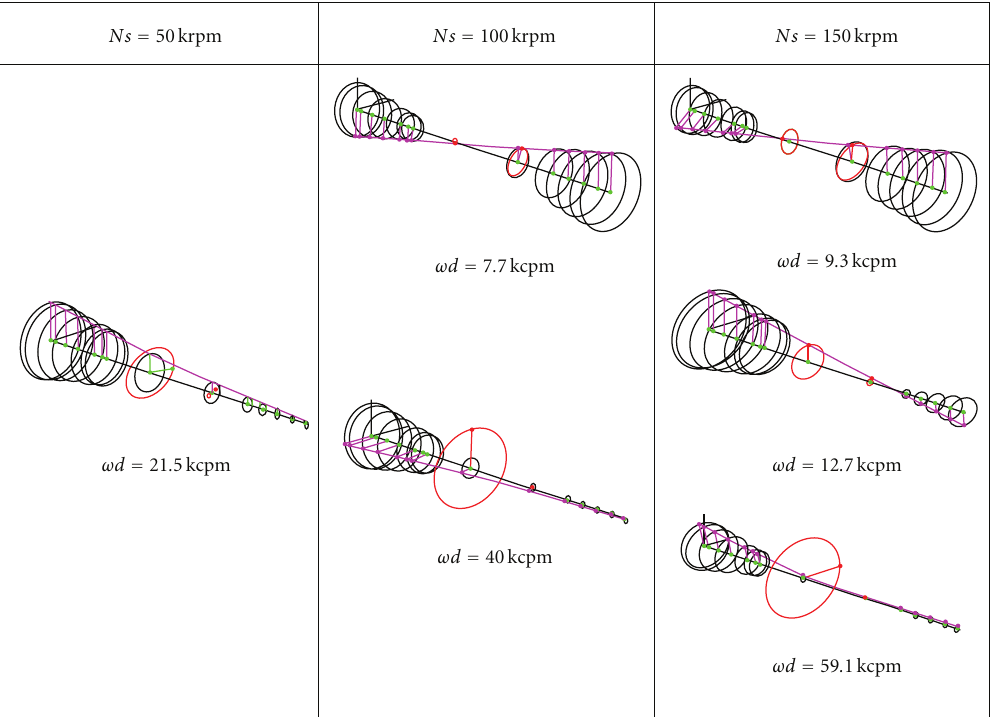
Figure 9: Predicted modes of instability for a turbocharger in two linearized floating ring